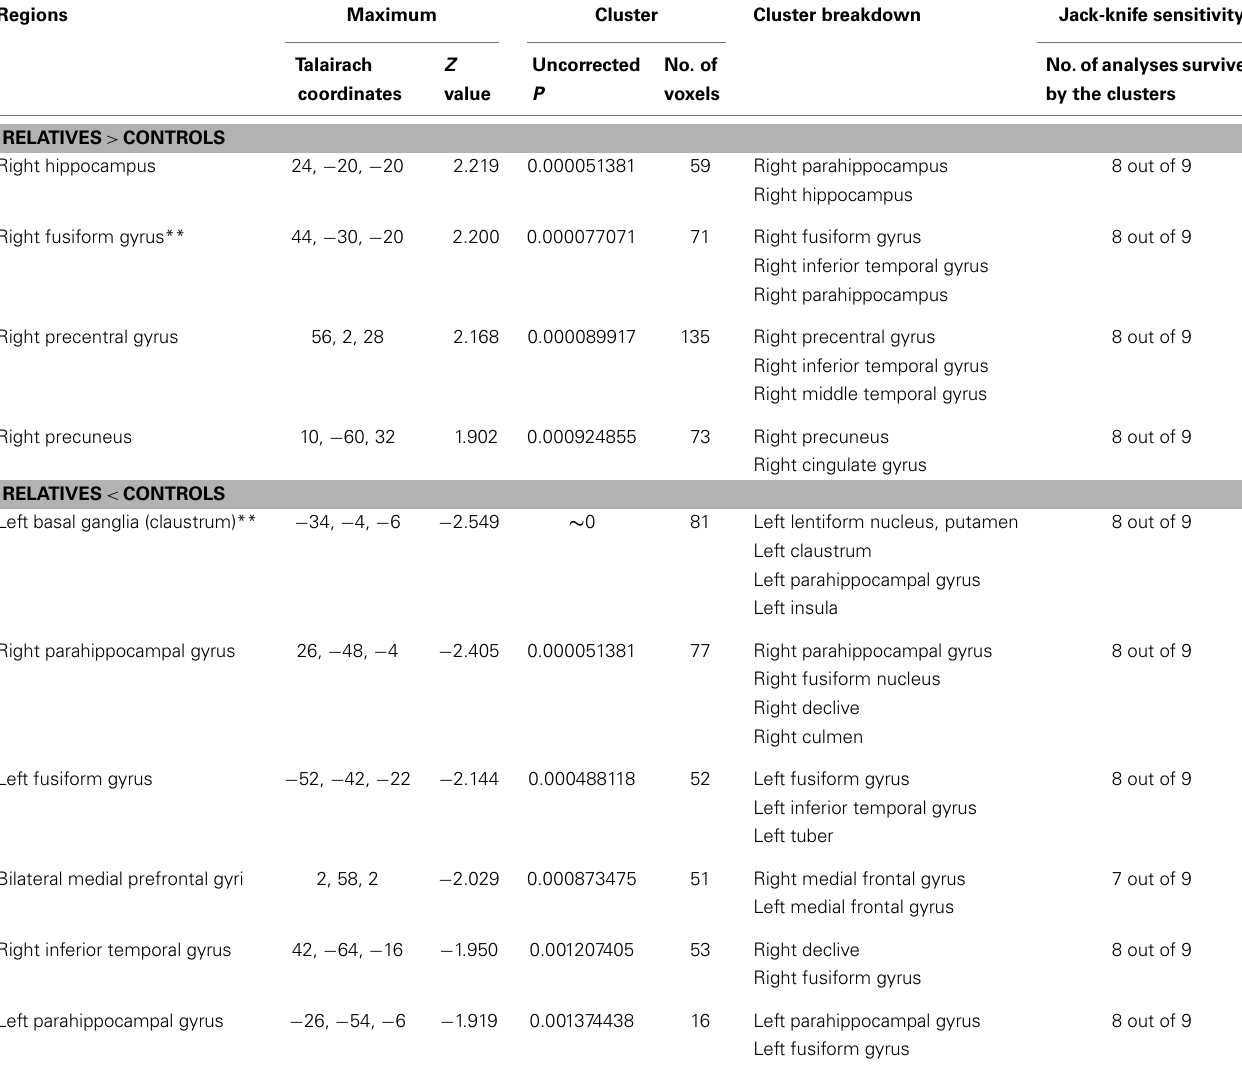
Table 4 | Gray matter differences between relatives of patients with schizophrenia and healthy controls .